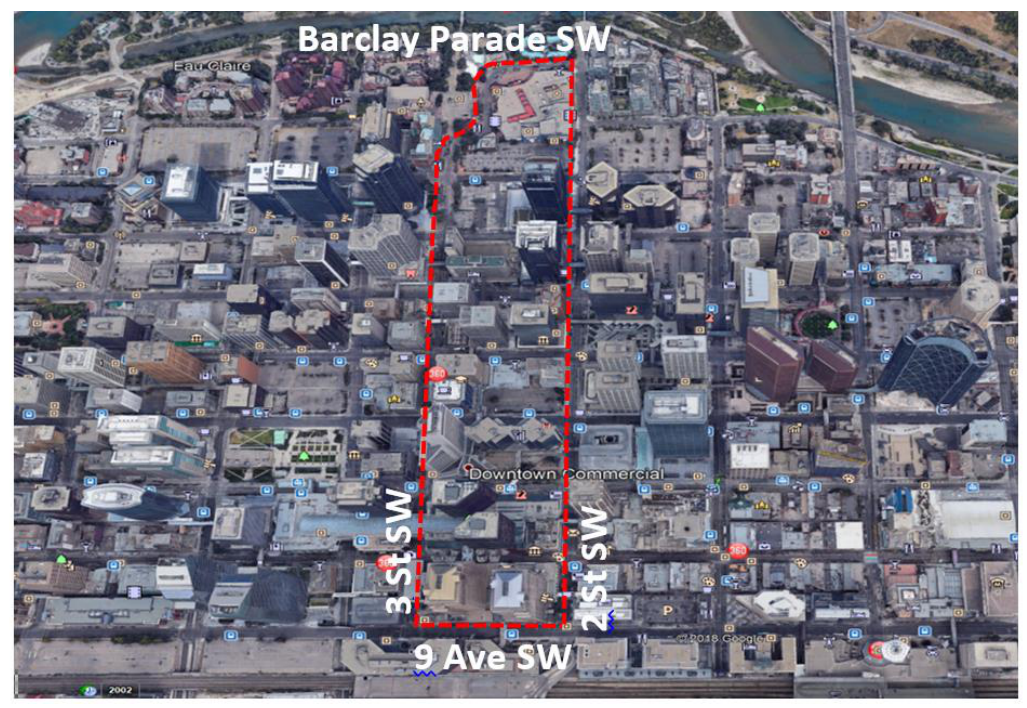
Figure 2. Top view of the study area (image from Google Maps). The dotted red line indicates the extents of the static laser scanner data.